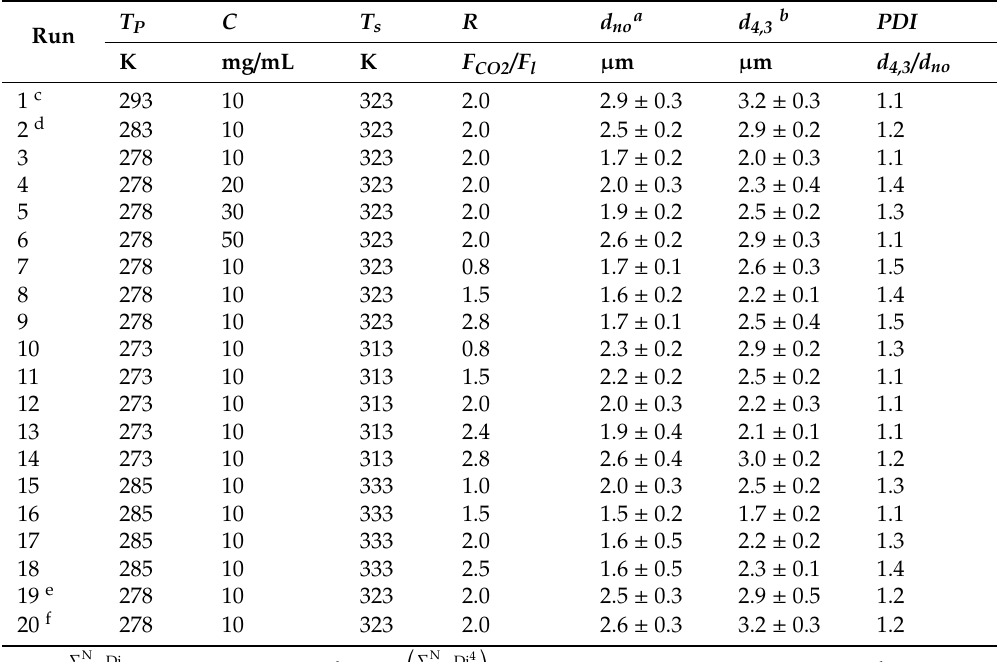
Table 3. Experimental conditions and results of PEG